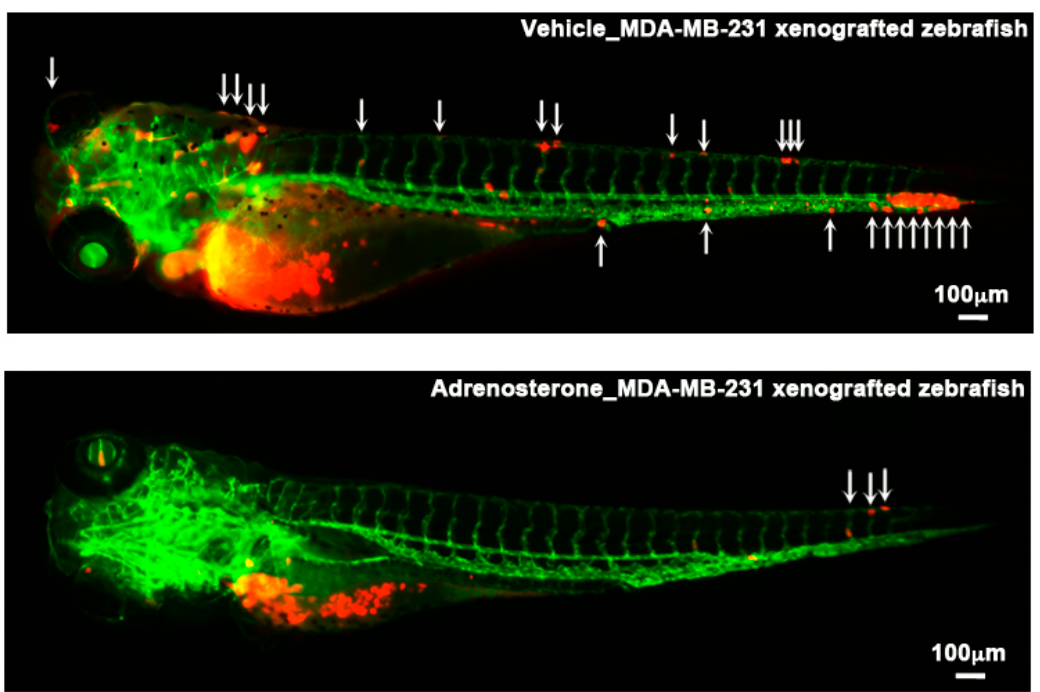
Figure 2. Examples of zebrafish xenograft models. Metastatic dissemination of red fluorescence protein (RFP)-labeled MDA-MB-231 cells in the vehicle-(top) or adrenosterone (bottom)-treated Tg(kdrl: EGFP) fish. The cells are inoculated into the duct of Cuvier of the fish at 48 hpf and then treated with either vehicle or adrenosterone for 24 h. White arrows indicate disseminated MDA-MB-231 cells. Images are shown in 4 × magnification. Scale bar = 100 µ m. Images are reprinted from